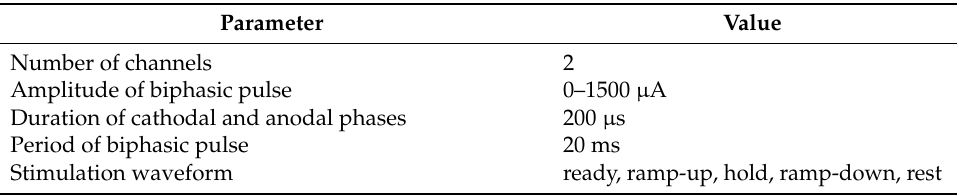
Table 4. Electrical characteristics of the neural stimulator.